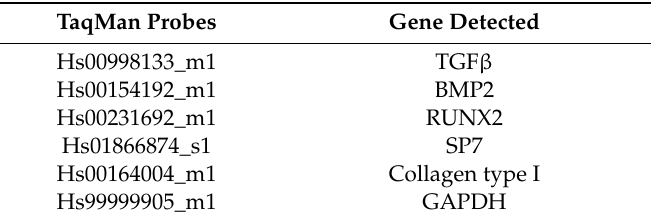
Table 1. TaqMan probes and PCR primers used in the